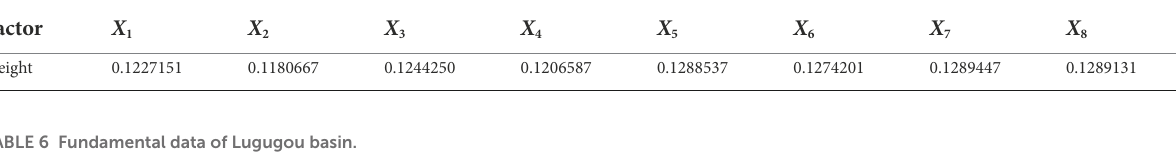
TABLE 6 Fundamental data of Lugugou basin. Debris flow